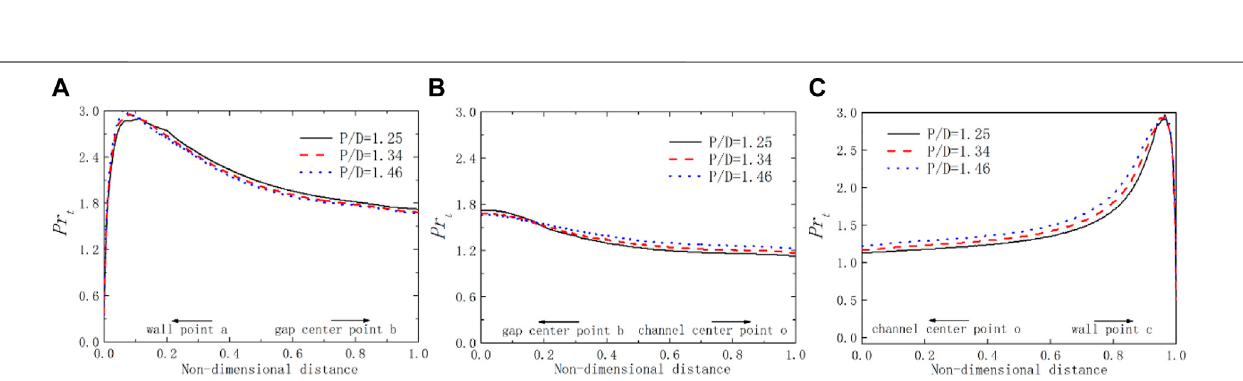
FIGURE 14 | Schematic diagram of turbulent Prandtl number over lines for the square lattice at Pe = 2000 with different P/D ratios. (A) line ab; (B) line bo; (C) line oc.